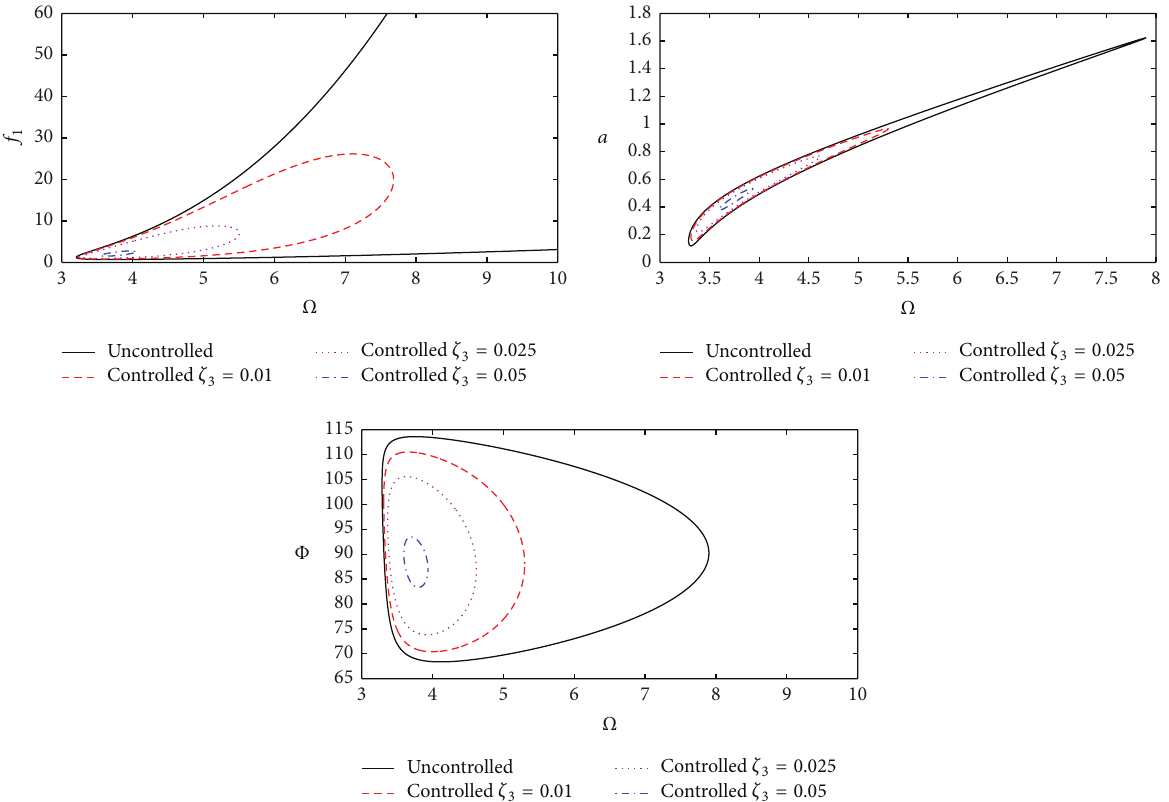
Figure 13: Existence regions, amplitude-frequency, and phase-frequency relationships of the 1/3 subharmonic resonance for the controlled system under different feedback gain 𝜁 3 without time delay ( 𝜁 1 = 0.025 , 𝑘 = 1 ,